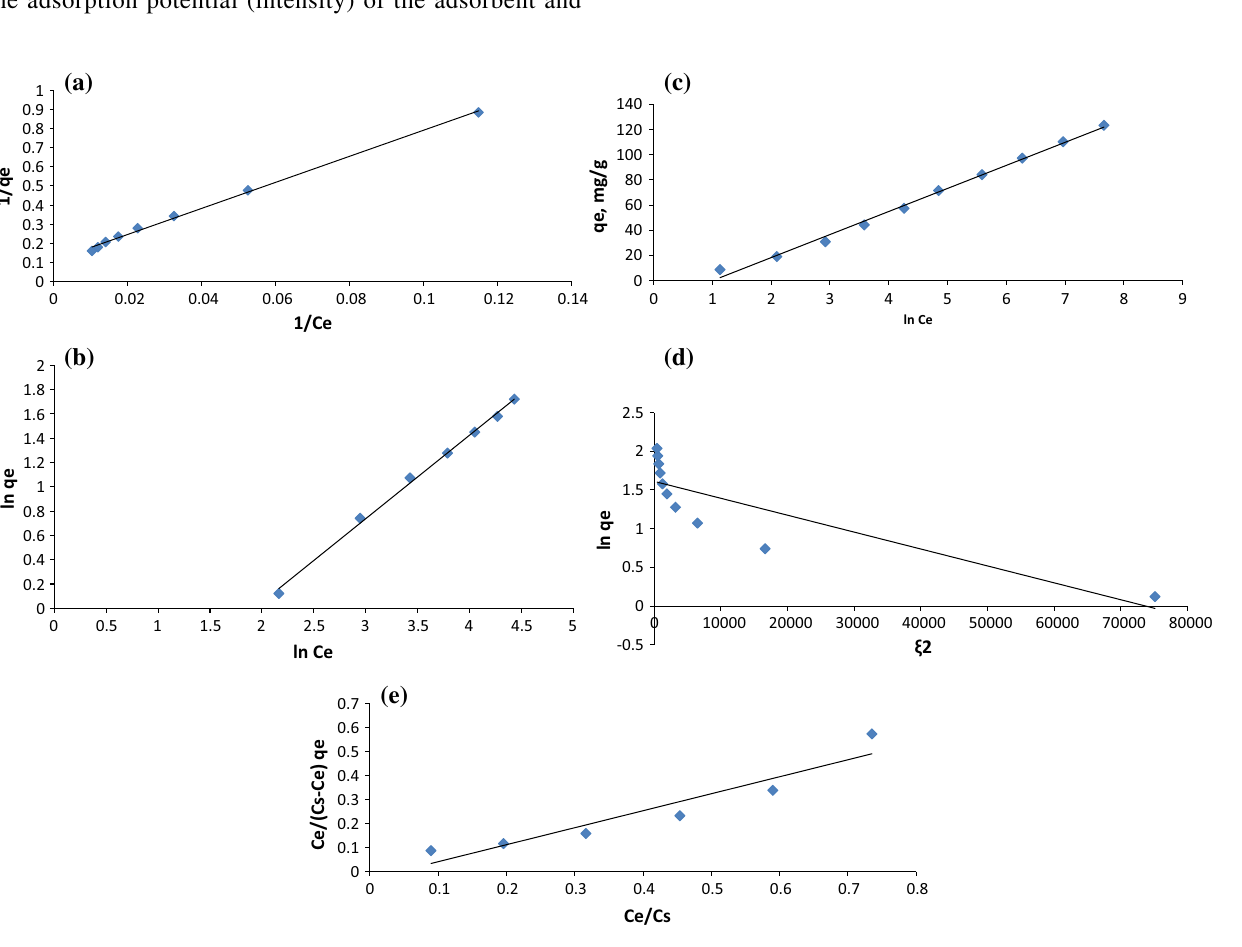
Fig. 3 Isotherm of adsorption of Ni(II). a Langmuir, b Freundlich, c Temkin, d Dubinin–Radushkevich, e BET [initial Ni(II) conc. = 20–200 mg/L; pH = 7.0; ABL dose = 1 g; temperature = 303